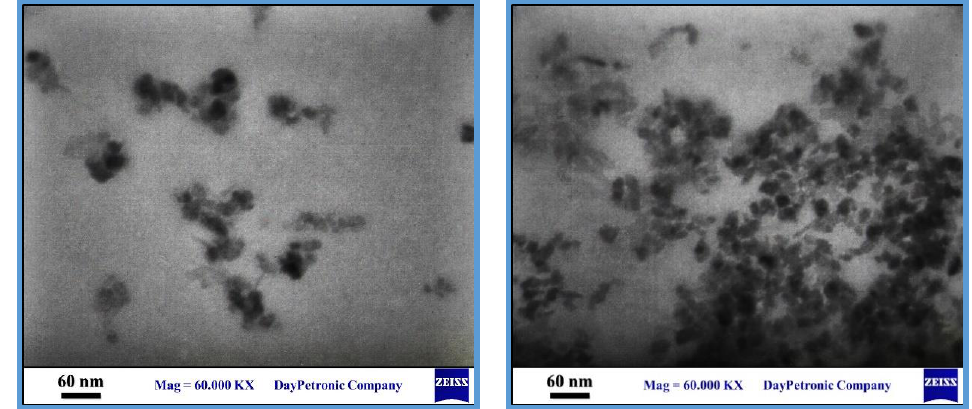
Figure 5. TEM images of the Mn-supported nano-catalyst.